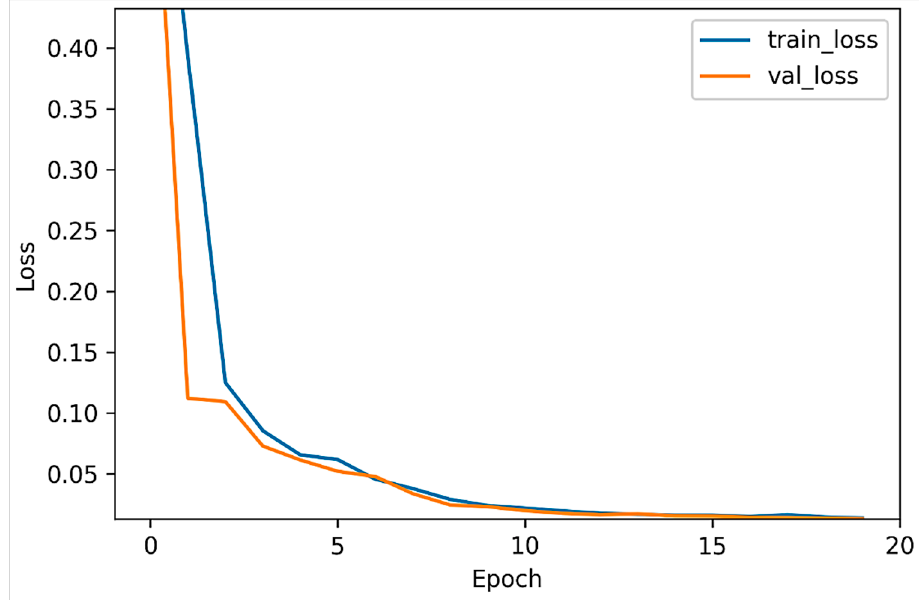
Figure 6. VAE loss in training and validation sets (ASD-diagnosed set).